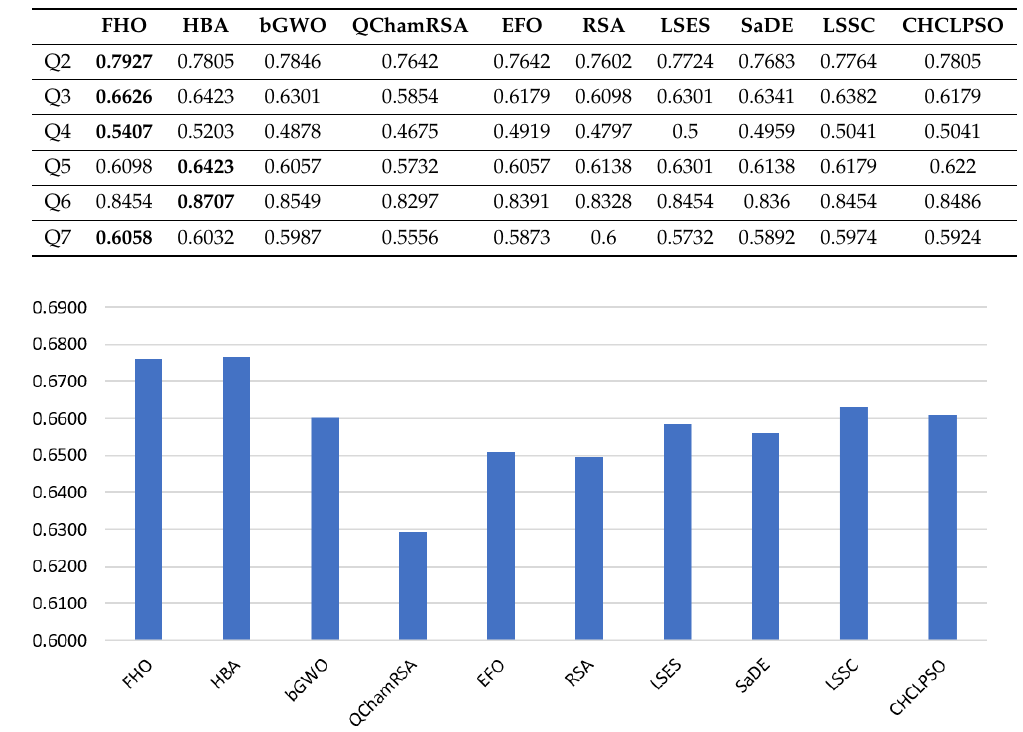
Table 8. Accuracy results for the multi-class experiment.